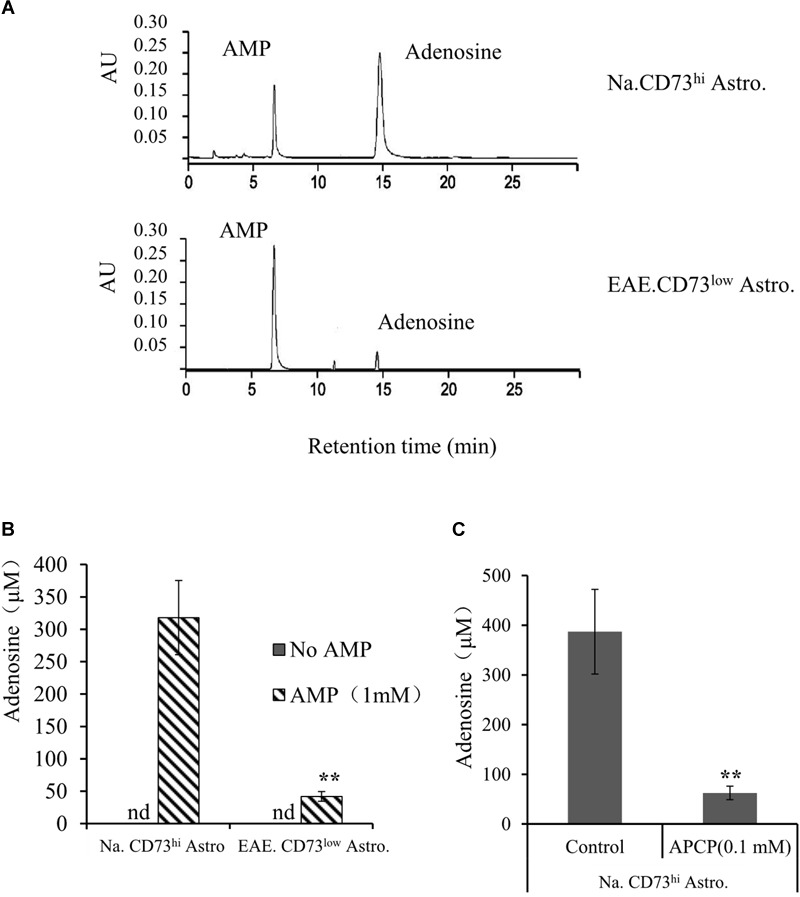
Decreased ability of EAE astrocytes to convert 5′-AMP to adenosine. Brain astrocytes were isolated from naïve and EAE-induced B6 mice by autoMACS. The enzymatic activity of CD73 was represented as the ability to convert 5′-AMP (1 mM) to adenosine in 1 h. Adenosine levels in the reactions were measured by an HPLC-based method. ∗∗Indicates statistically significant differences (p < 0.01). (A) HPLC detection of adenosine levels in reactions with Na.CD73hi – and EAE.CD73low astrocytes. (B) Detected adenosine levels in reactions containing naïve and EAE astrocytes, with or without the addition of 5′-AMP (n = 6). (C) Detected adenosine levels in reactions containing naïve CD73hi astrocytes, with or without the addition of a CD73 inhibitor, APCP (0.3 mM) (n = 6).